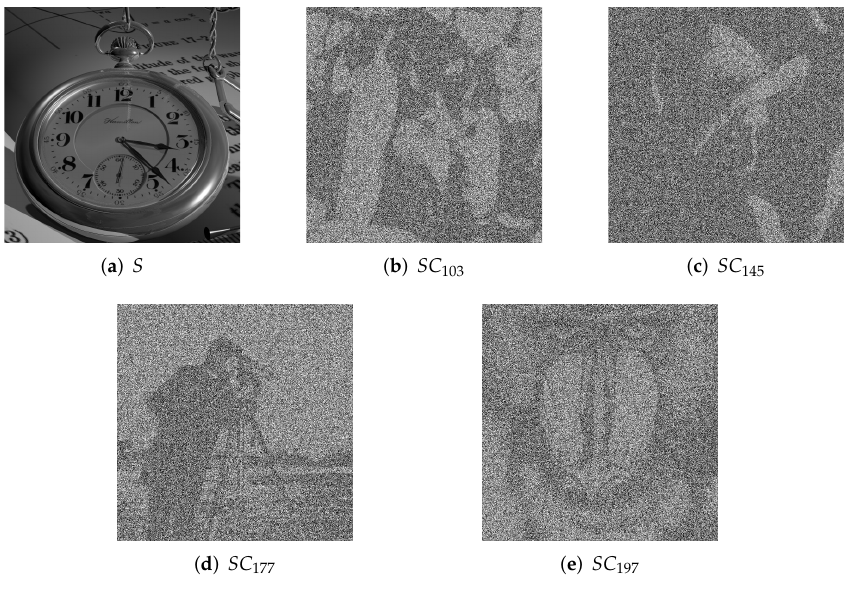
Figure 7. Experiment 2 of thumbnail secret